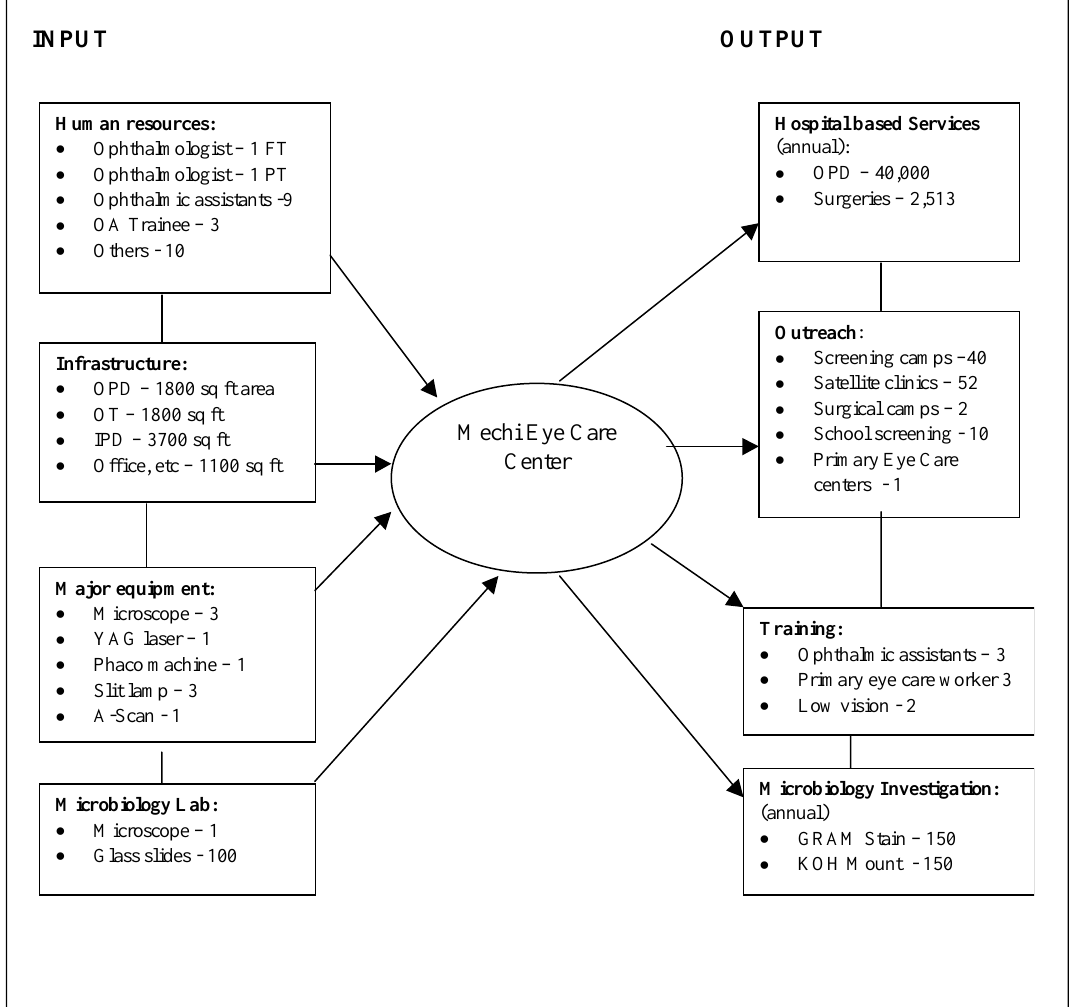
Fig. 1. Mechi Eye Care Center: an overview